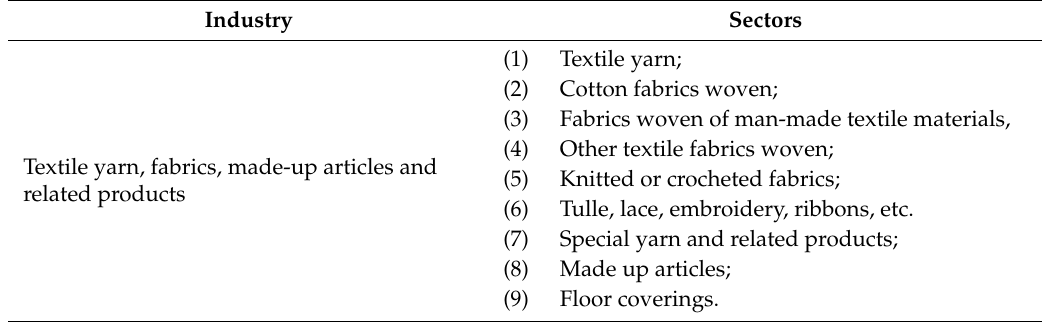
Table 8. Sectors classification of index 65, textile raw materials.